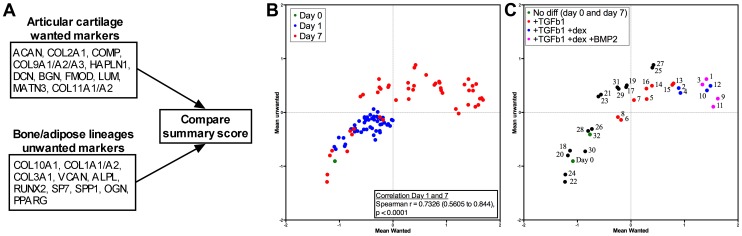
Analysis of wanted and unwanted gene expression.
A. Gene sets used to compute mean expression of wanted and unwanted markers. B. Scatter-plot of the mean expression (studentized values) of wanted (x-axis) and unwanted (y-axis) markers at day 0, 1 and 7 of all conditions. C. Scatter-plot of the mean expression (studentized values) of wanted and unwanted markers at day 0 and 7 for condition 1–32.